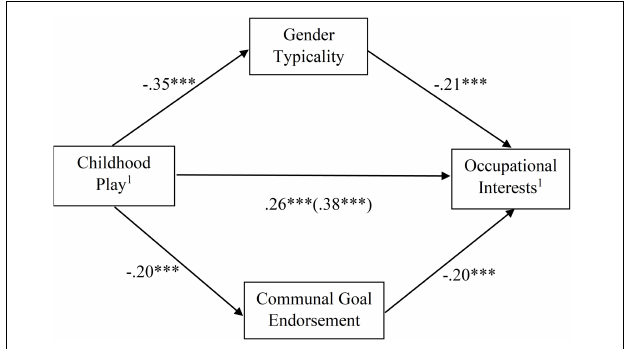
FIGURE 2 | Final multiple mediator model in women. 1 Higher scores on these measures indicate higher male-typical/lower female-typical traits. Standardised coefficients are reported. For the path from gender-related childhood play to gender-related occupational interests, the coefficient within the brackets indicates the total effect (without considering the mediators) and the coefficient outside the brackets indicates the direct effect (after taking into account the mediators). In this model, the relation between childhood play and occupational interests became weaker after the mediators were introduced, indicating partial mediation. ∗ p < 0.05, ∗∗ p < 0.01, ∗∗∗ p < 0.001.